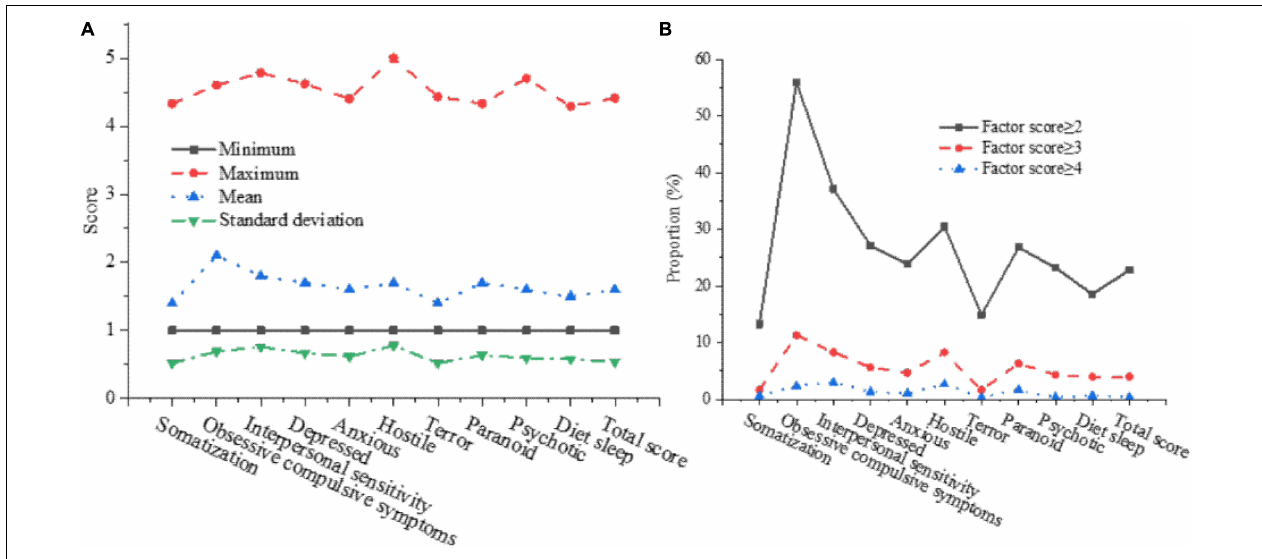
FIGURE 5 | The statistical results of mental health level of college students. (A) Overall situation of mental health level. (B) Detection rate of mental health problems.